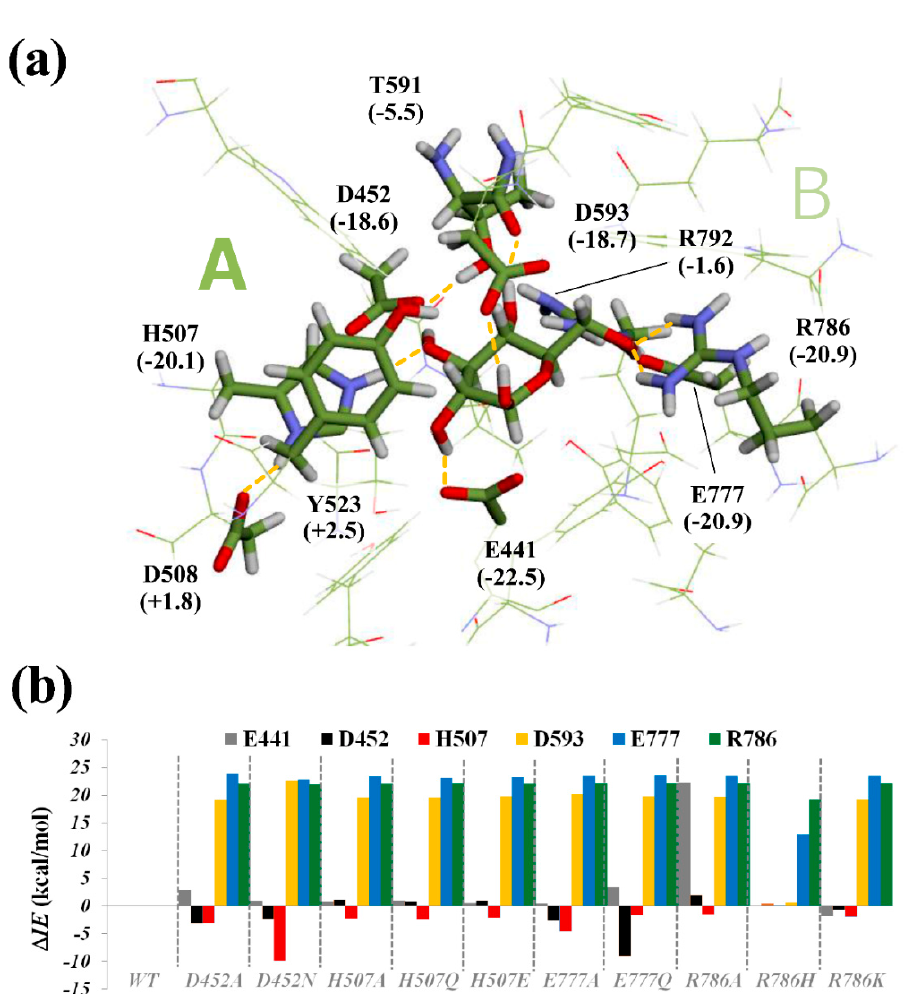
Figure 8. ONIOM2-optimized structure of wild type (WT) Tx GH116-glucose complex ( a ) and change in particular interaction energy ( Δ IE) between glucose and six important residues for different mutations ( b ). The residues analyzed were those with |IE| > 15 kcal mol − 1 in Figure S13, and the mutations analyzed were D452A, D452N, H507A, H507Q, H507E, E777A, E777Q, R786A, R786H, and R786K) ( b ). Geometries were obtained at ONIOM2(B3LYP/6-31G(d,p):PM3) level of theory. All energies in the bar plot for the mutants are relative to the IE values of WT (shown in parentheses in ( a ) in kcal mol − 1 ). The energies were calculated at the B3LYP/6-31G(d,p) level with BSSE-CP. Negative and positive Δ IE values mean the particular residue stabilizes and destabilizes the glucose binding, respectively. The hydrogen bonds are displayed as orange dash lines.